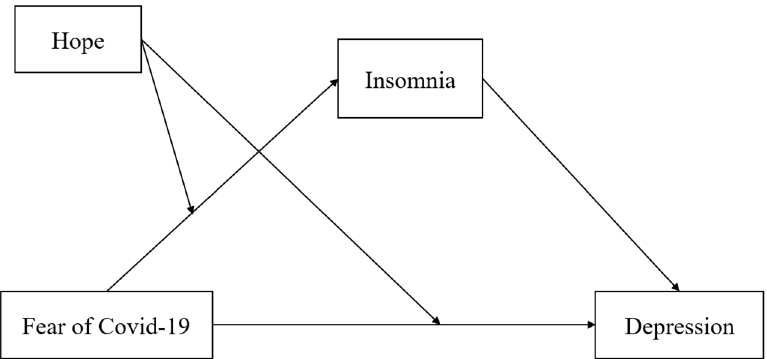
Figure 1. The mediated moderation model in the study.